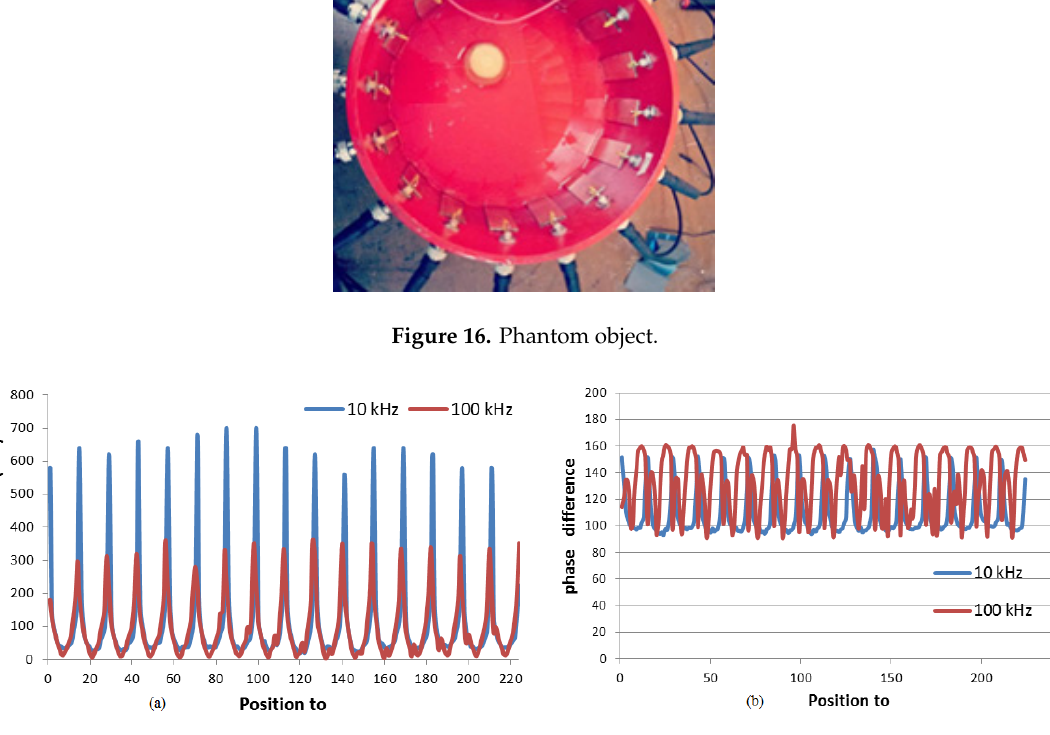
Figure 17. ( a ) Data of electric potential from the scanning using Neighboring method. ( b ) Data of phase difference from the scanning using Neighboring method.